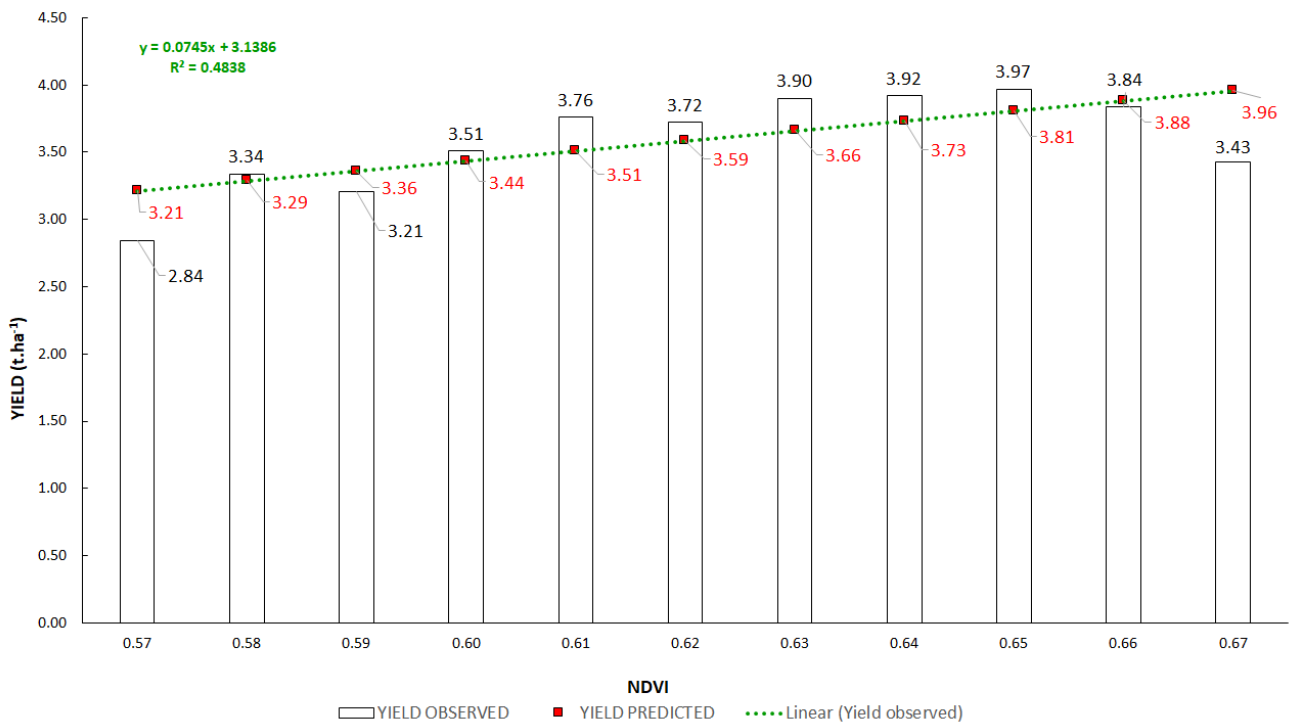
Figure 10. Graph of the variance of YIELD variable in relation to the measured NDYI values (N = 80). Source data (red squares) show the yields of each plot ( Y − axis) divided into 17 groups according to NDYI measured on each plot, ranging from 0.47 to 0.63 (17 values; X − axis). The parcels in each of the 17 groups have the same NDYI value.